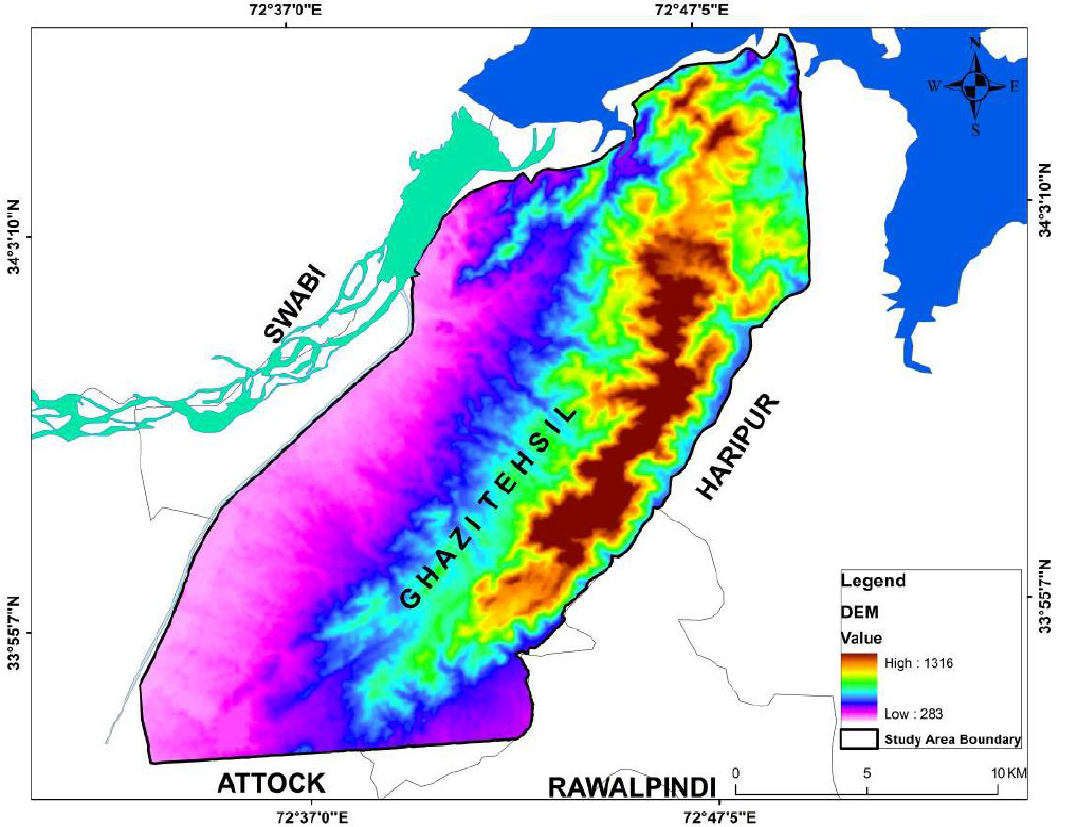
Figure 6. DEM (30 meters) of Ghazi tehsil. The maximum elevation of the area is 1316 meters and Figure 6. DEM (30 m) of Ghazi tehsil. The maximum elevation of the area is 1316 m and the minimum the minimum is 283 meters (above sea level) (data source: ASTER GDEM website). is 283 m (above sea level) (data source: ASTER GDEM